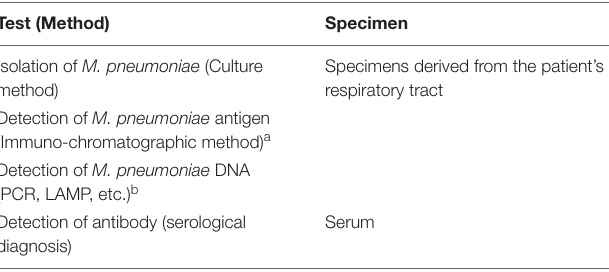
TABLE 1 | Tests required for notification of Mycoplasma pneumoniae pneumonia from sentinel